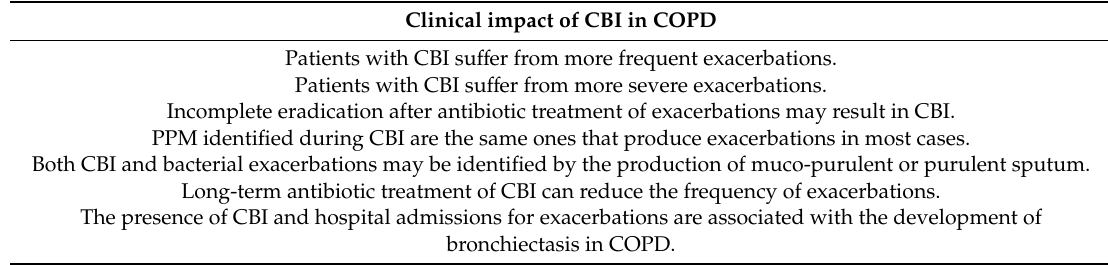
Table 2. Relationship between chronic bronchial infection (CBI) and bacterial exacerbations of COPD. Clinical impact of CBI in COPD Patients with CBI su ff er from more frequent